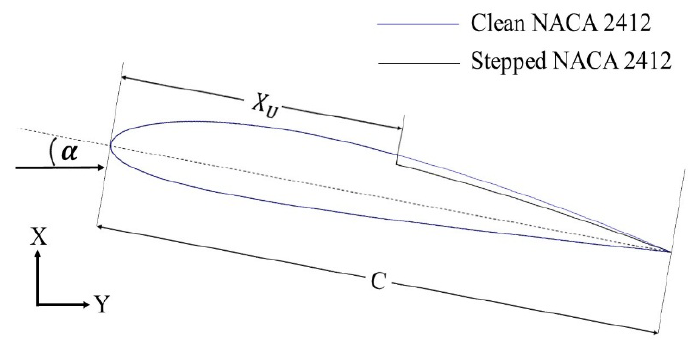
Figure 2. A schematic diagram of a clean NACA 2412 (National Advisory Committee for Aeronautics) overlaying the stepped NACA 2412 airfoil.